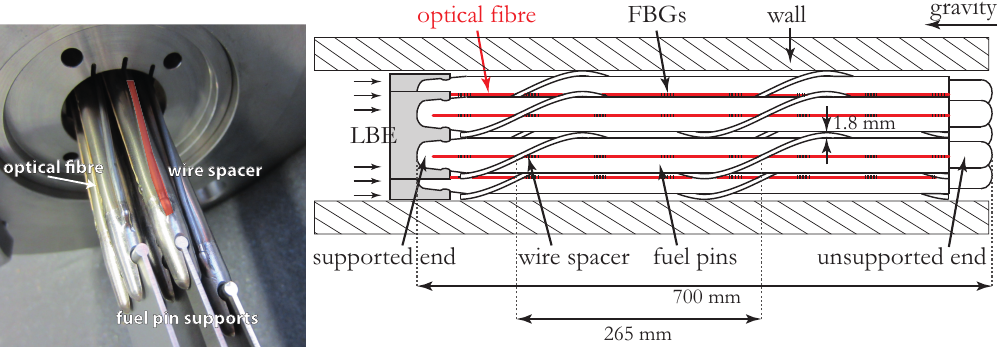
Figure 1. Concept drawing and photograph of the seven-pin fuel